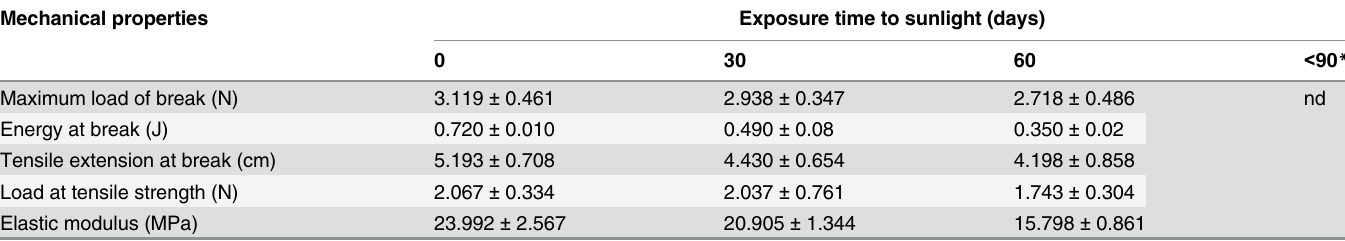
Table 2. Mechanical properties of the green polyethylene before and after 30, 60, 90 and 120 days of exposure to sunlight. Mechanical properties